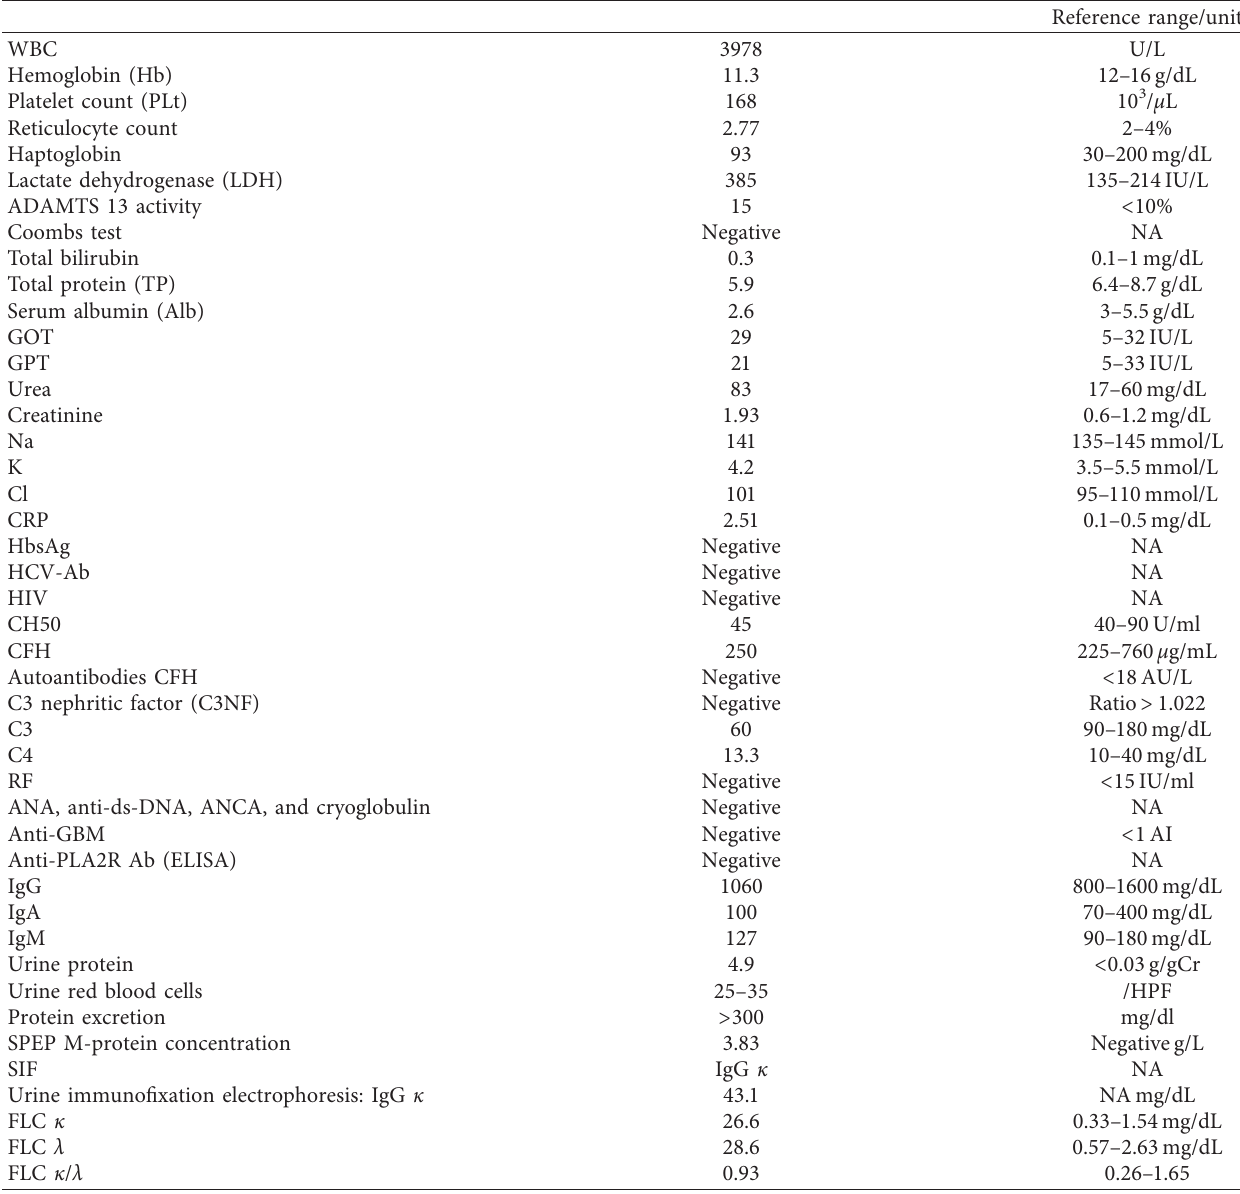
Table 1: Laboratory findings on